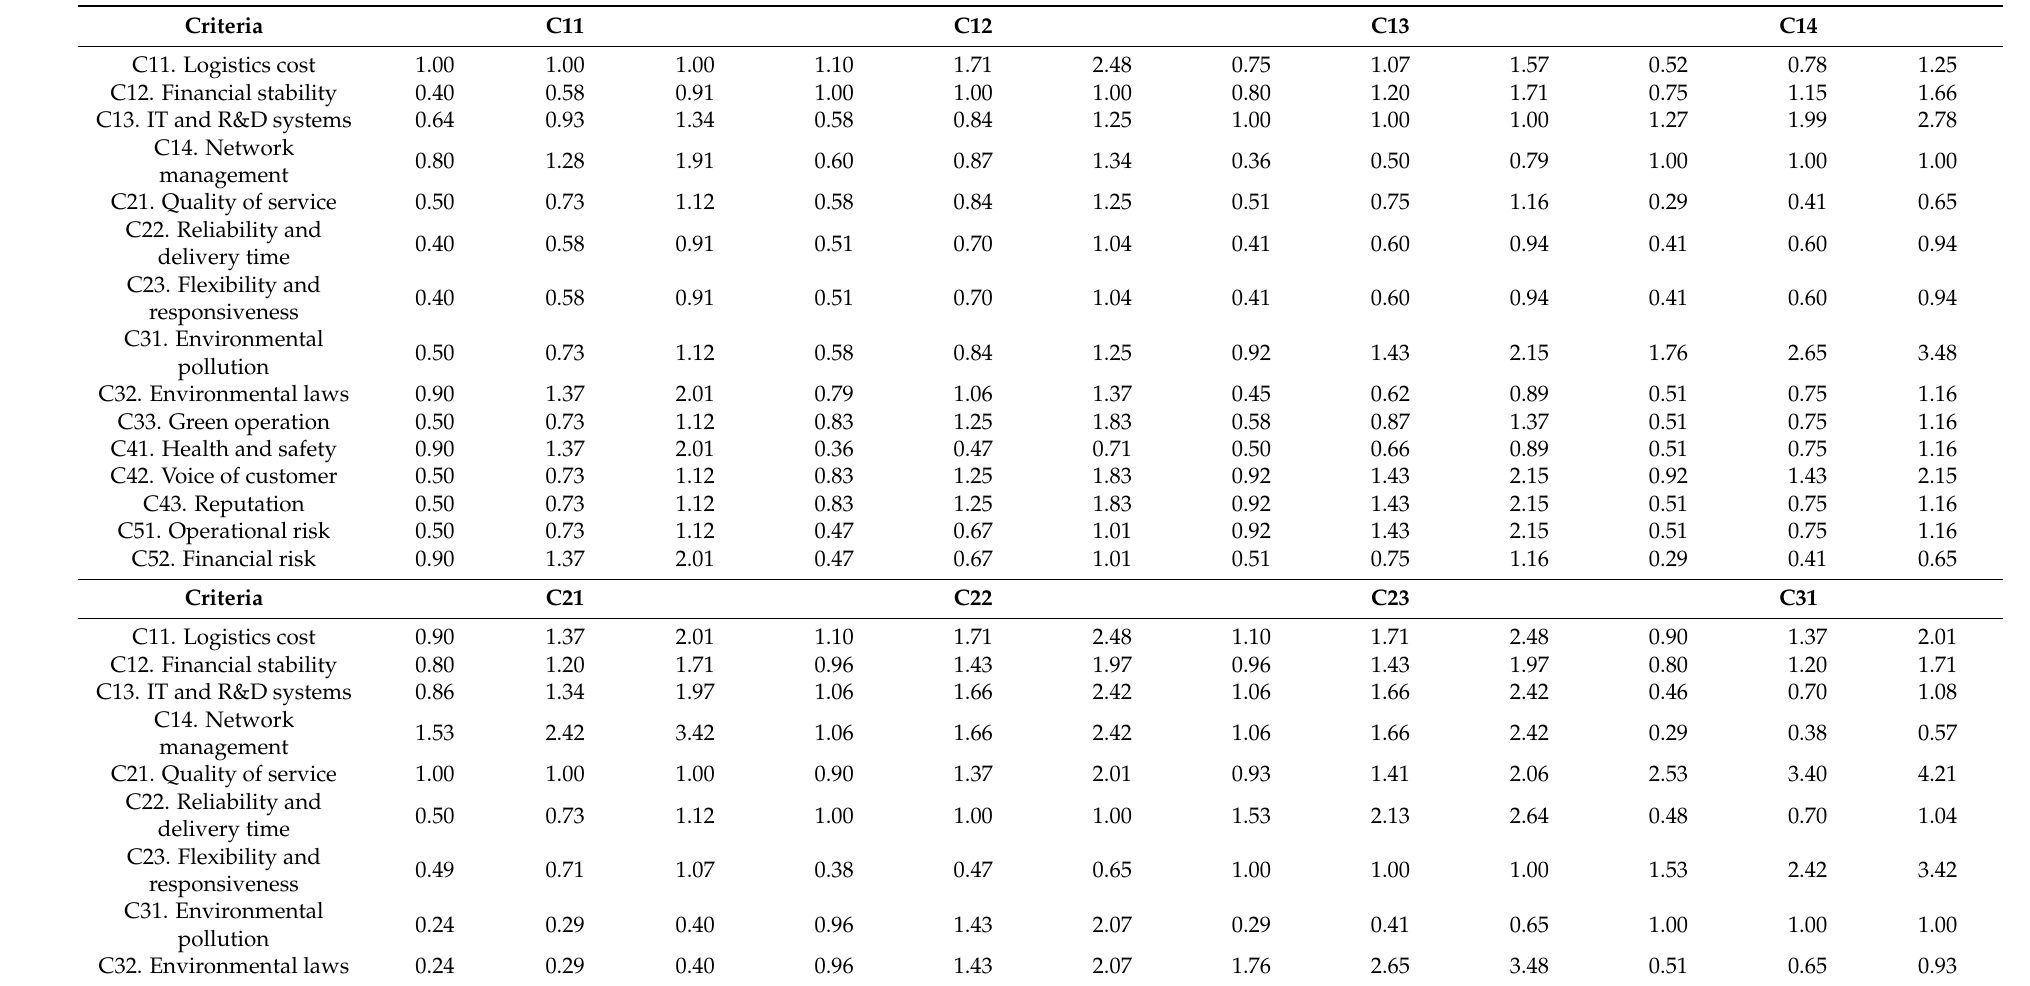
Table A1. The aggregated fuzzy comparison matrix of FAHP